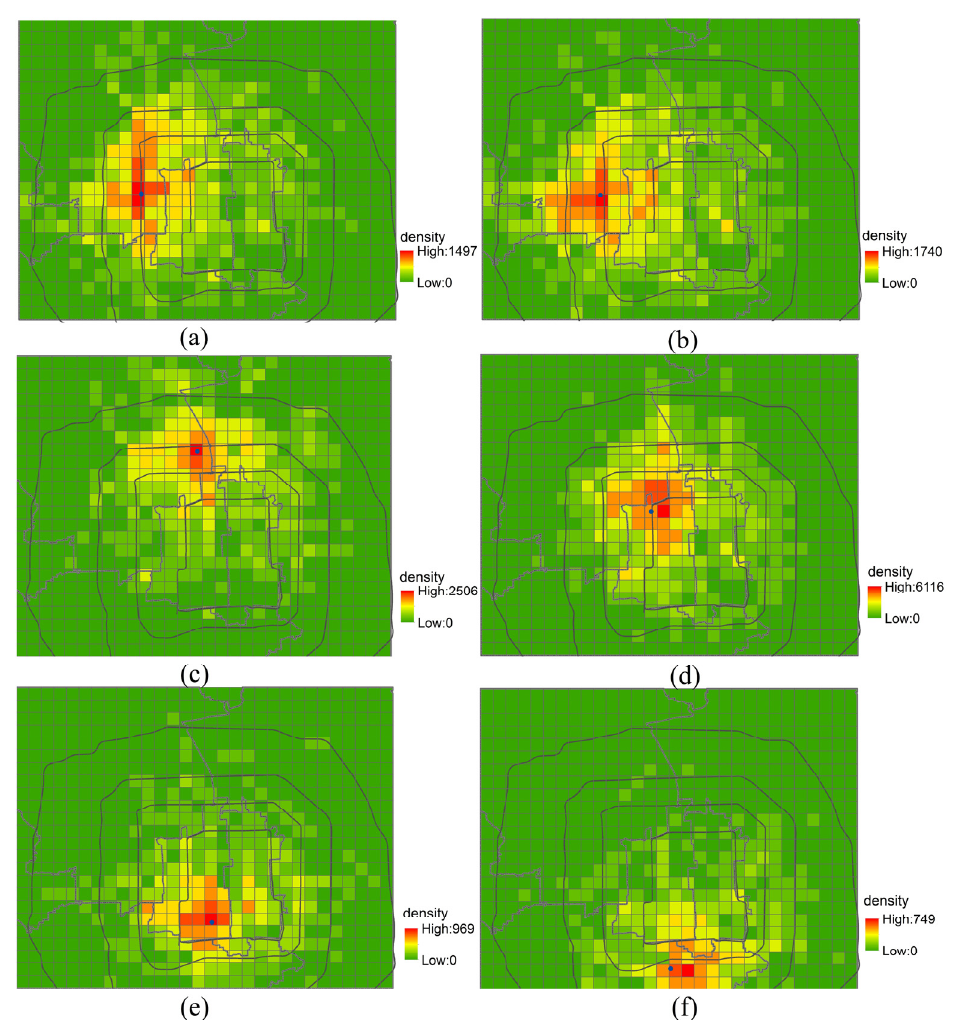
Figure 5. Hospital service areas. ( a ) The First Affiliated Hospital of PLA General Hospital (#304 Hospital); ( b ) Air Force General Hospital; ( c ) Peking University Third Hospital; ( d ) Peking University People’s Hospital; ( e ) Xicheng Woman and Children Health Hospital; ( f ) Fengtai Maternal & Child Health Hospital.